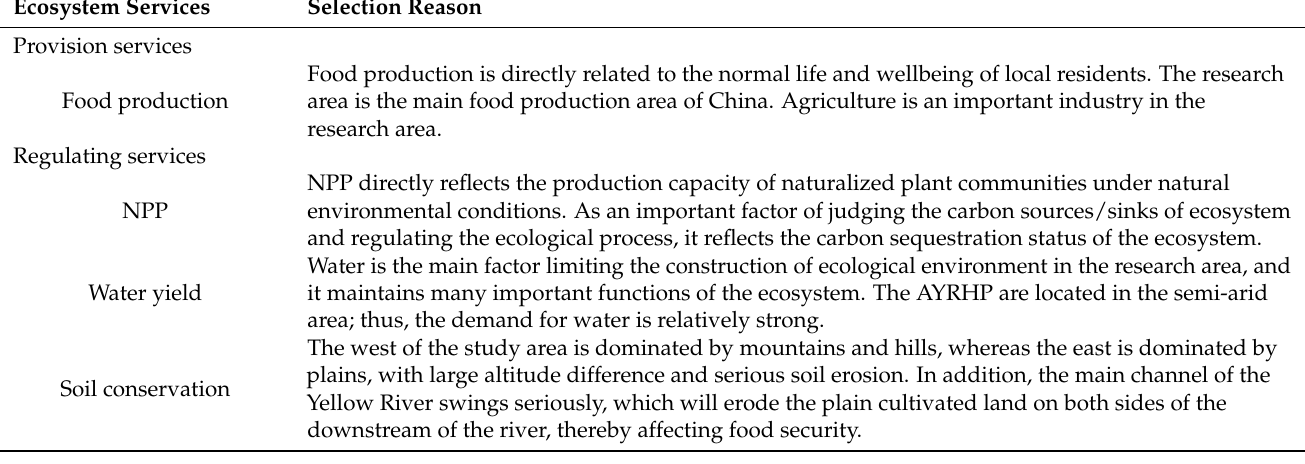
Table 2. Criteria for selecting ESs in the AYRHP.